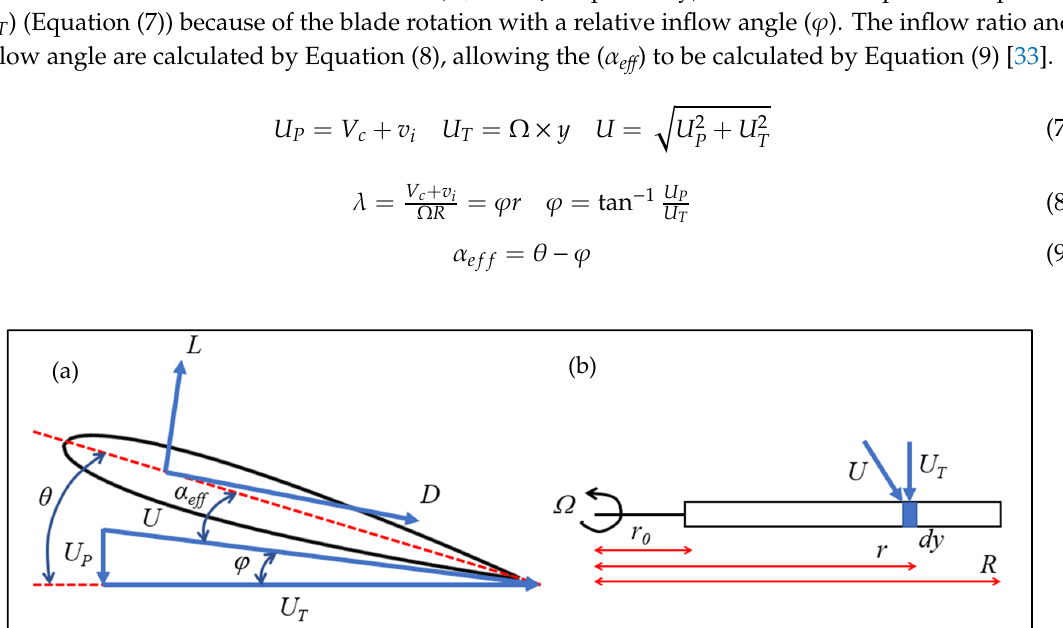
Figure 3. Rotor blade with velocity and force vectors: a) side view; b) top view.